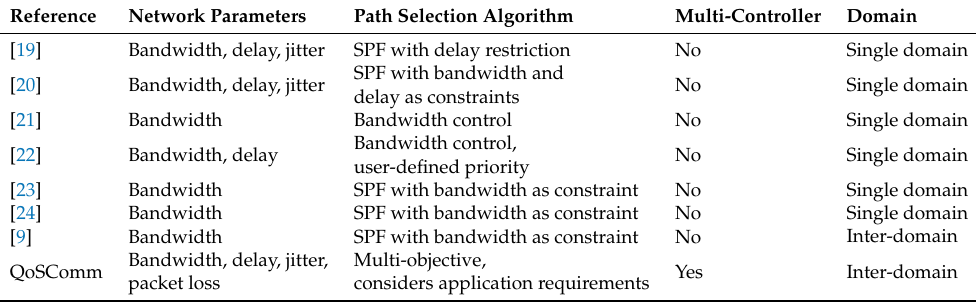
Table 1. QoS proposals features